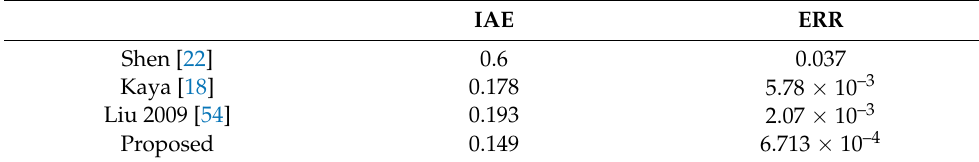
Figure 24. The Bode plots for process G P6 . Table 13. The criteria values for the process G P6